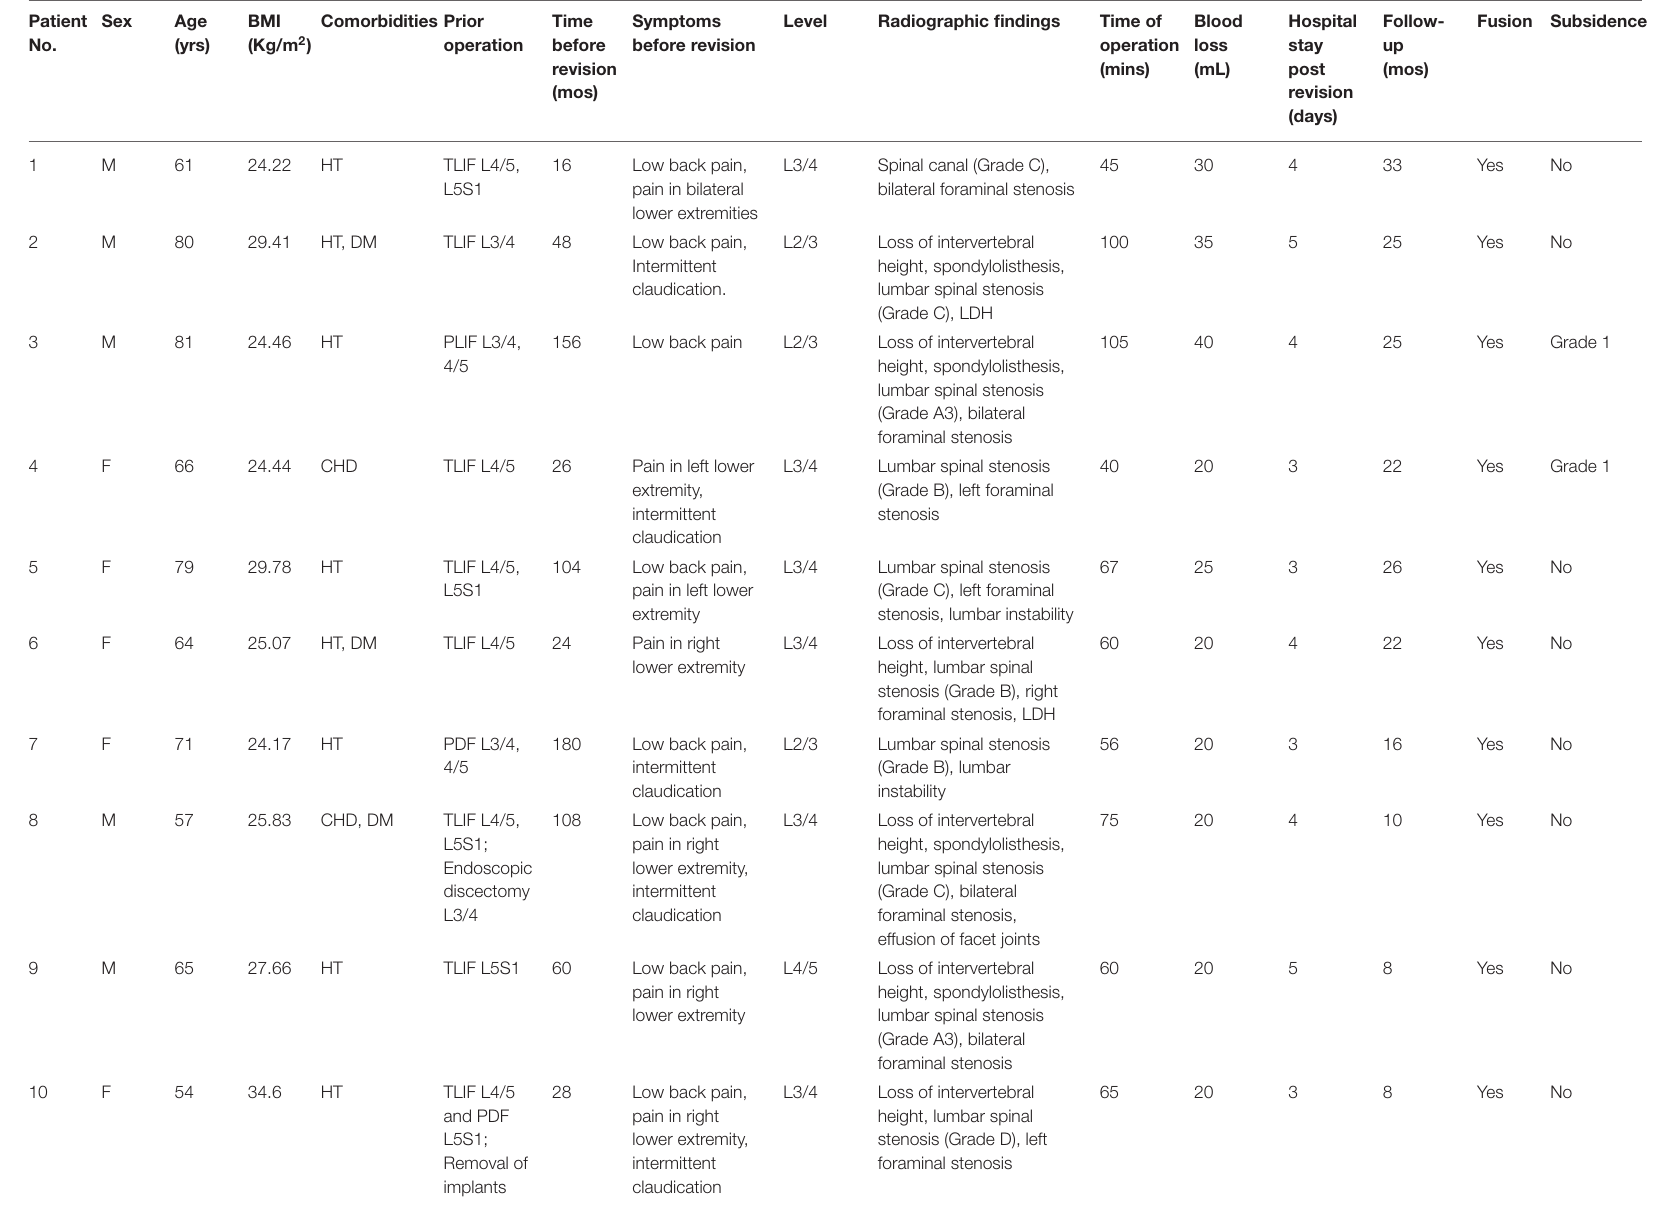
TABLE 1 | Summary of patient demographics and surgical characteristics. Patient